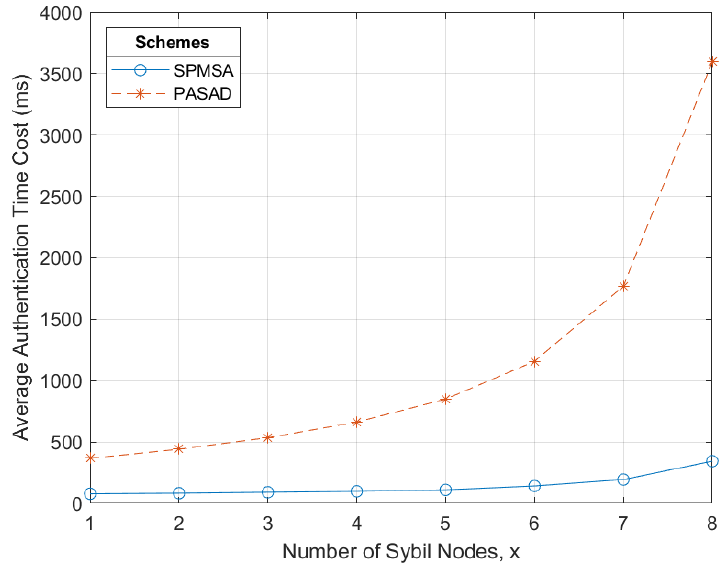
Figure 16. Performance of the Two Schemes in the Presence of Sybil Nodes.